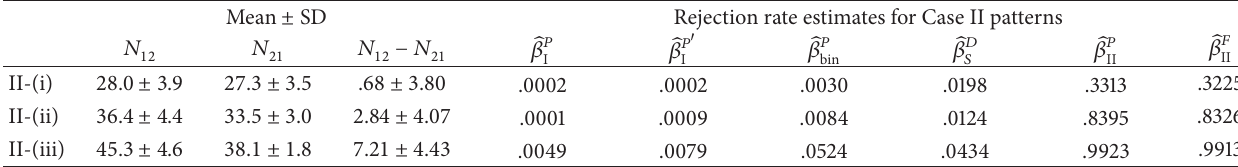
Table 8: The means ( ± SD) of the off-diagonal entries, 𝑁 12 , 𝑁 21 , and their difference 𝑁 12 − 𝑁 21 and the rejection rate estimates for Case II = 10000 , 𝑛 = 𝑛 = 40 at 𝛼 = .05 . Column labeling is as in Table 6. patterns in (34) with 𝑁 1 2 mc